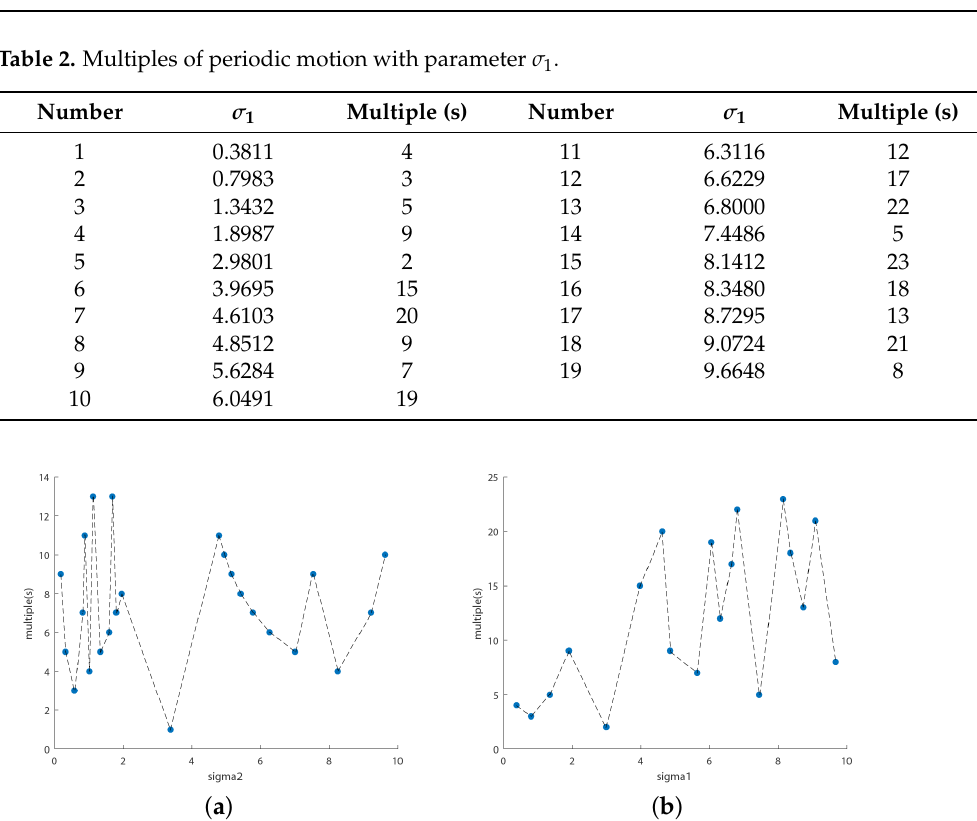
Figure 12. The scatter plots between multiple periods and free parameter: ( a ) Free parameter σ 2 ; ( b ) Free parameter σ 1